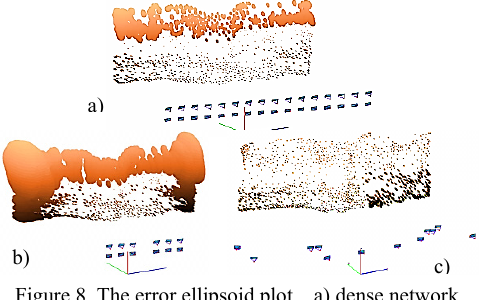
Figure 8. The error ellipsoid plot a) dense network